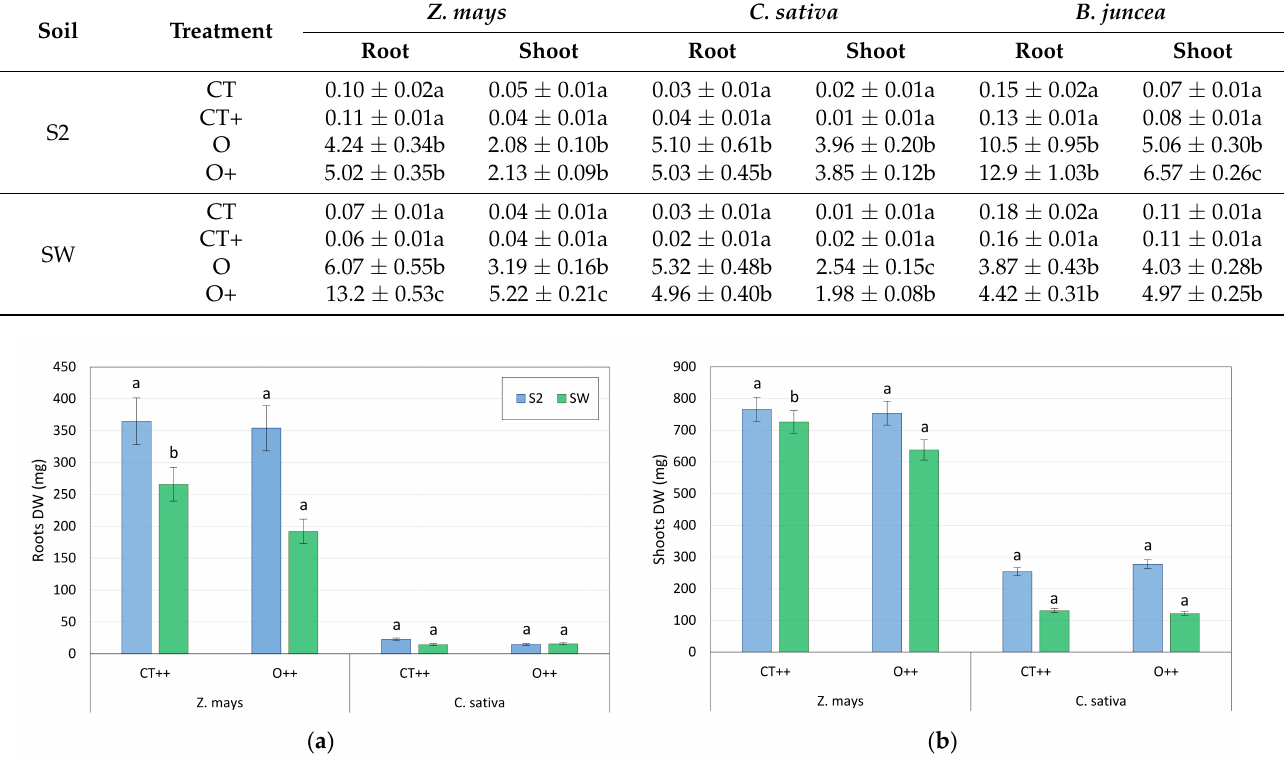
Figure 8. Dry weight (mg pot − 1 ) of ( a ) roots and ( b ) shoots of Z. mays and C. sativa grown on soil control (CT) and As-contaminated soil treated with oxalate (O). The addition of PGPR bacteria (second set of isolates) is indicated with the “++” sign. Values are the mean of three replicates, and the error bars show the standard deviation. Values with different letters are significantly different at the 5% probability level (Tukey’s